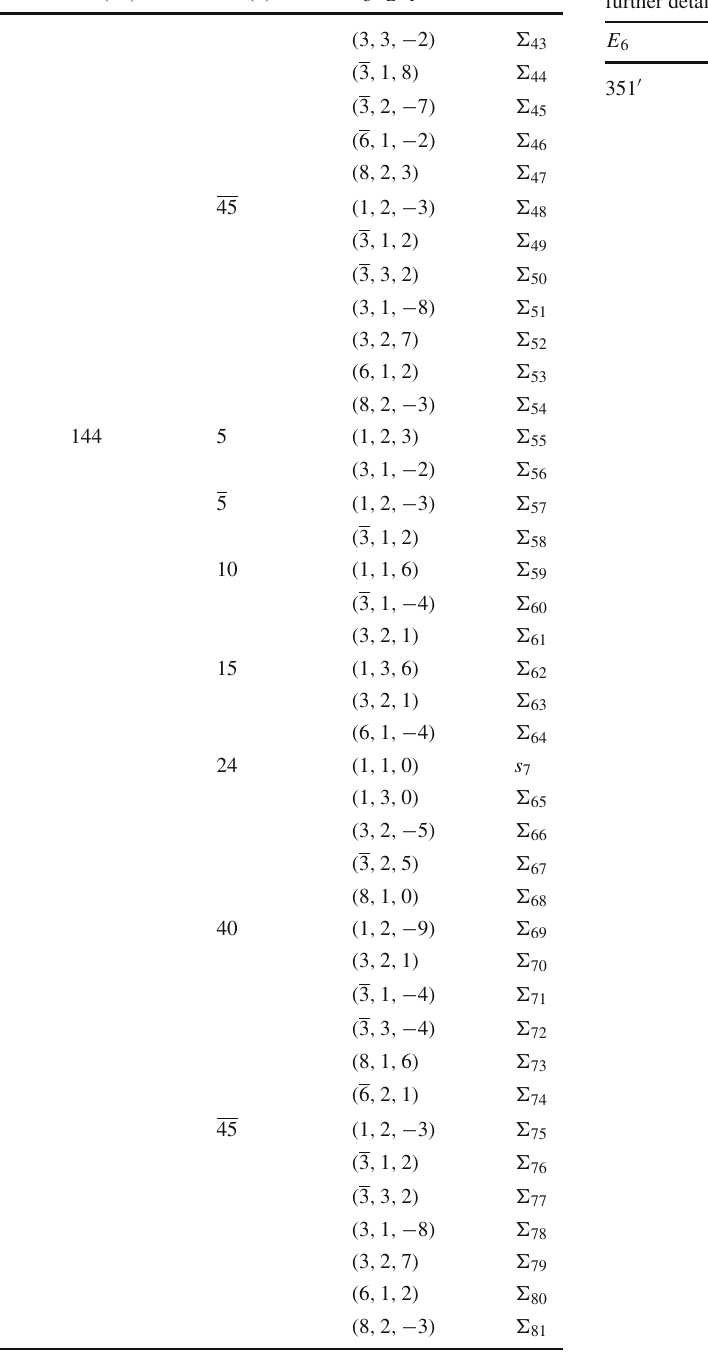
Table 9 Decomposition of the 351 (cid:4) representation of E 6 with respect to the subgroups SO ( 10 ) , SU ( 5 ) and SU ( 3 ) C × SU ( 2 ) L × U ( 1 ) Y .